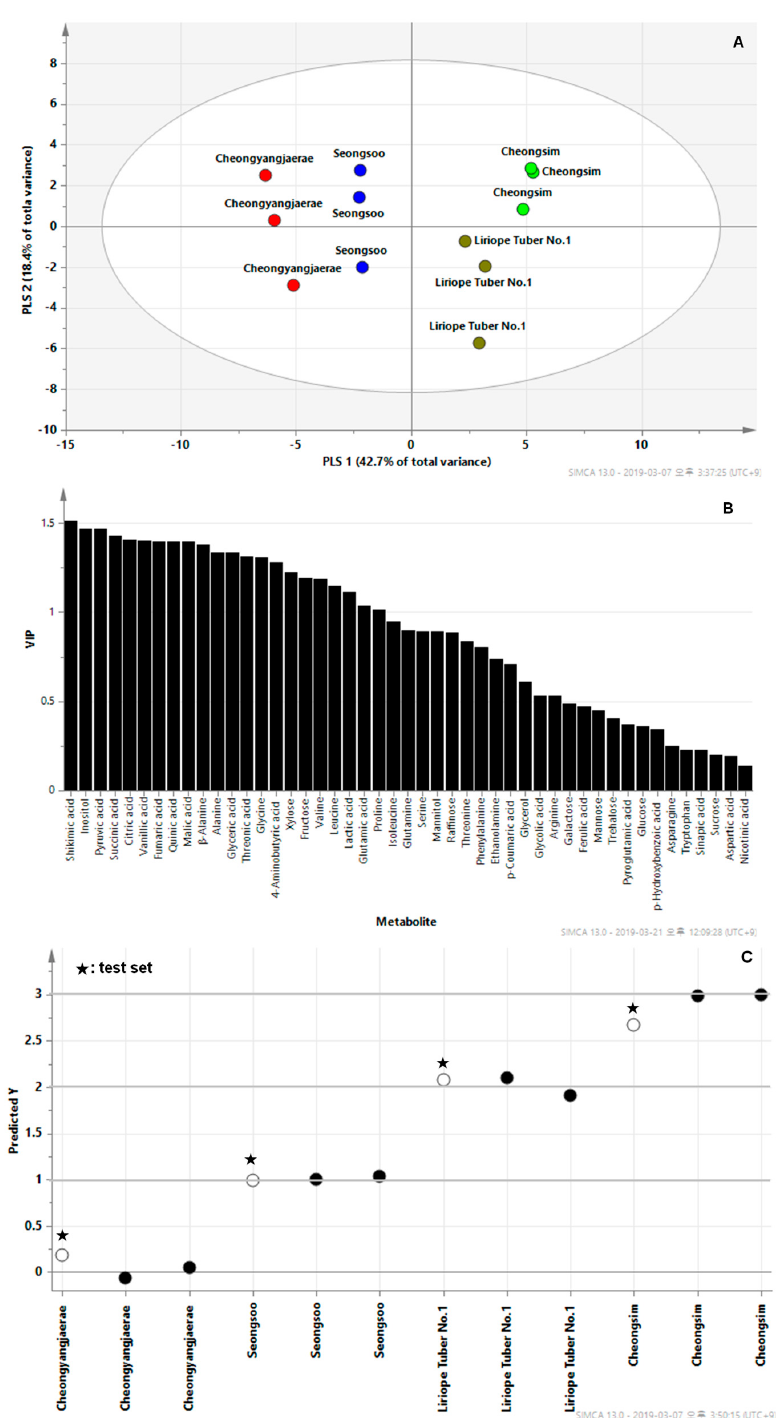
Figure 2. Score plots ( A ), variable importance in the projection (VIP) values ( B ), and external validation test ( C ) of partial least-squares discriminant analyses (PLS-DA) model derived from 47 metabolites from L. platyphylla samples.